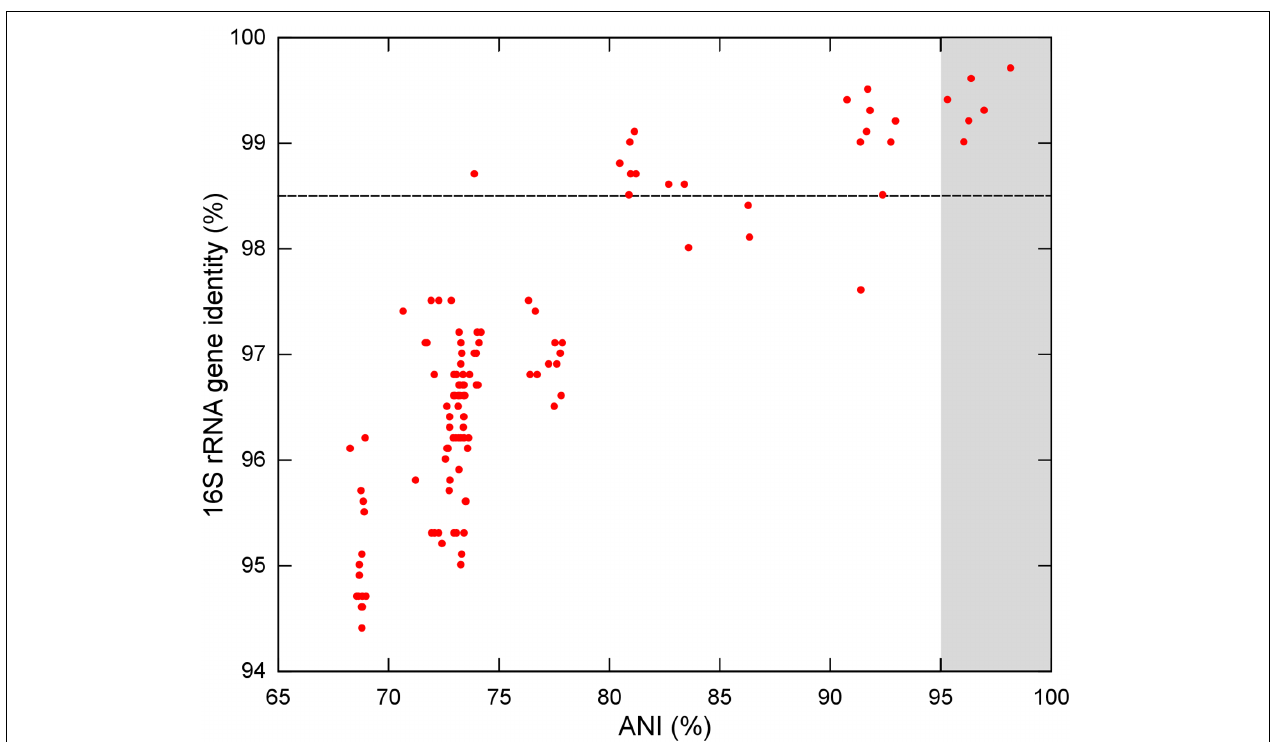
FIGURE 4 | Relationship between ANI and 16S rRNA gene identity levels among Paenibacillus species. Each red circle represents a comparison between two Paenibacillus species. Traced line shows the 16S rRNA gene identity threshold for species demarcation. Gray background represents the ANI range for species demarcation. All six red circles over the gray background are pairwise comparisons of P. riograndensis , P. sonchi , Paenibacillus sp. CAR114, and Paenibacillus